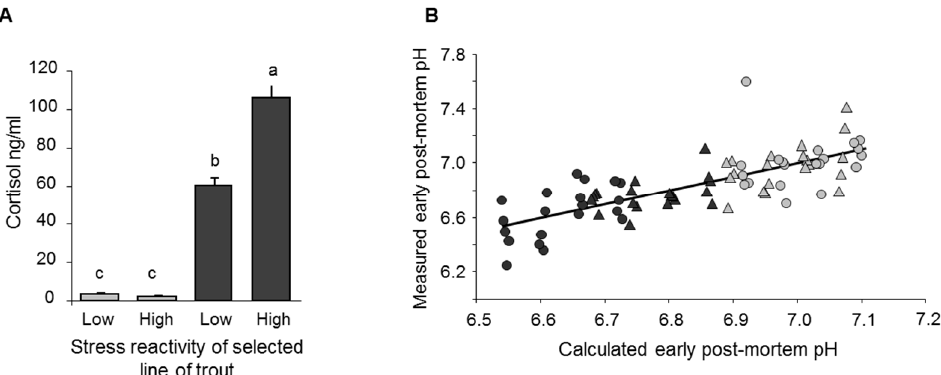
Figure 6. ( A ) Plasma cortisol levels of trout just before slaughter (bars where letters (a–c) differ have significantly different values ( p < 0.0001)) and ( B ) relationship between calculated and measured pH just after slaughter: pH = 6.8 − 0.003 × slaughter order +0.1 × high reactivity +0.4 × No additional stress at slaughter − 0.2 × high reactivity × No additional stress at slaughter. The equation explains 53.3% of the variability between individuals. Dark bars (A) and dark symbols (B) indicate slaughter following additional stress (15 min waiting in a tank with 20 cm depth of water). Triangles and circles indicate selection lines with high and low stress reactivity, respectively. Adapted from [61,81], with permission from INRAE, 2020 and Elsevier,